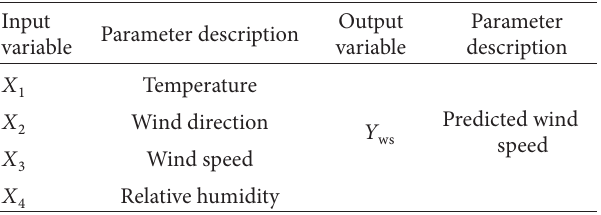
Table3:Inputandoutputvariablesoftheproposedensembleneural